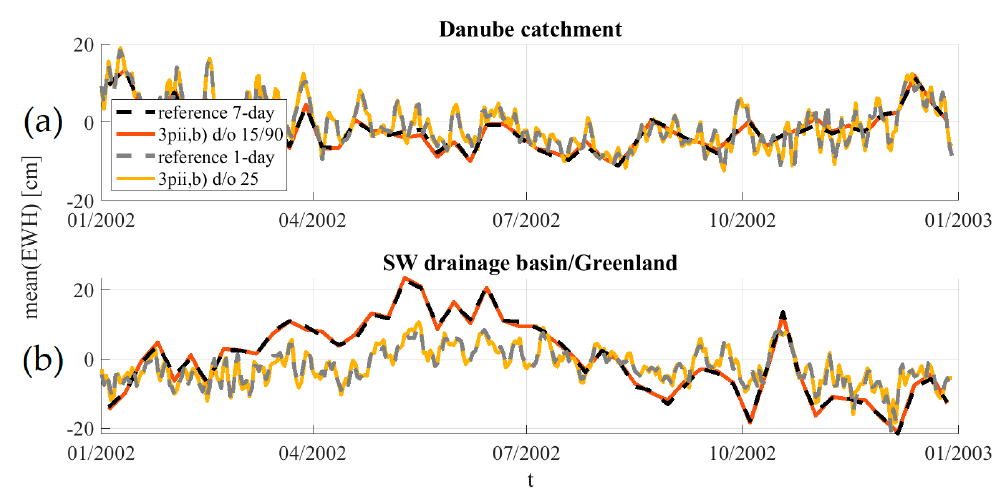
Figure 13. Time series in EWH (cm) for Danube catchment (a) and SW drainage basin in Greenland (b) of Scenario 3pii,b comparing daily solutions (d/o 25) to the signal content of the seven-day solution up to d/o 50 of scenario 3pii,b for one year.